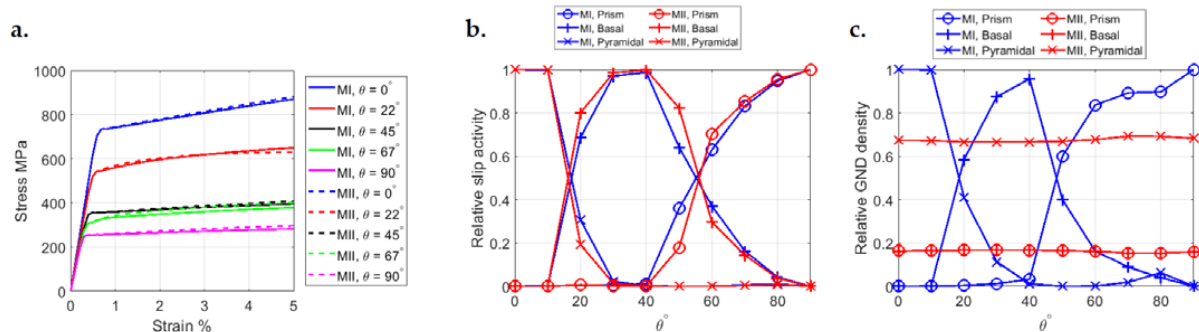
Figure 3. ( a ) The average stress-strain curve, ( b ) relative slip activity, and ( c ) relative GND density calculated for a single crystal with different c-axis misorientation with the loading direction ( θ ). Comparisons are made for Method I (M I) as well as Method II (M II) of the CPFE model.